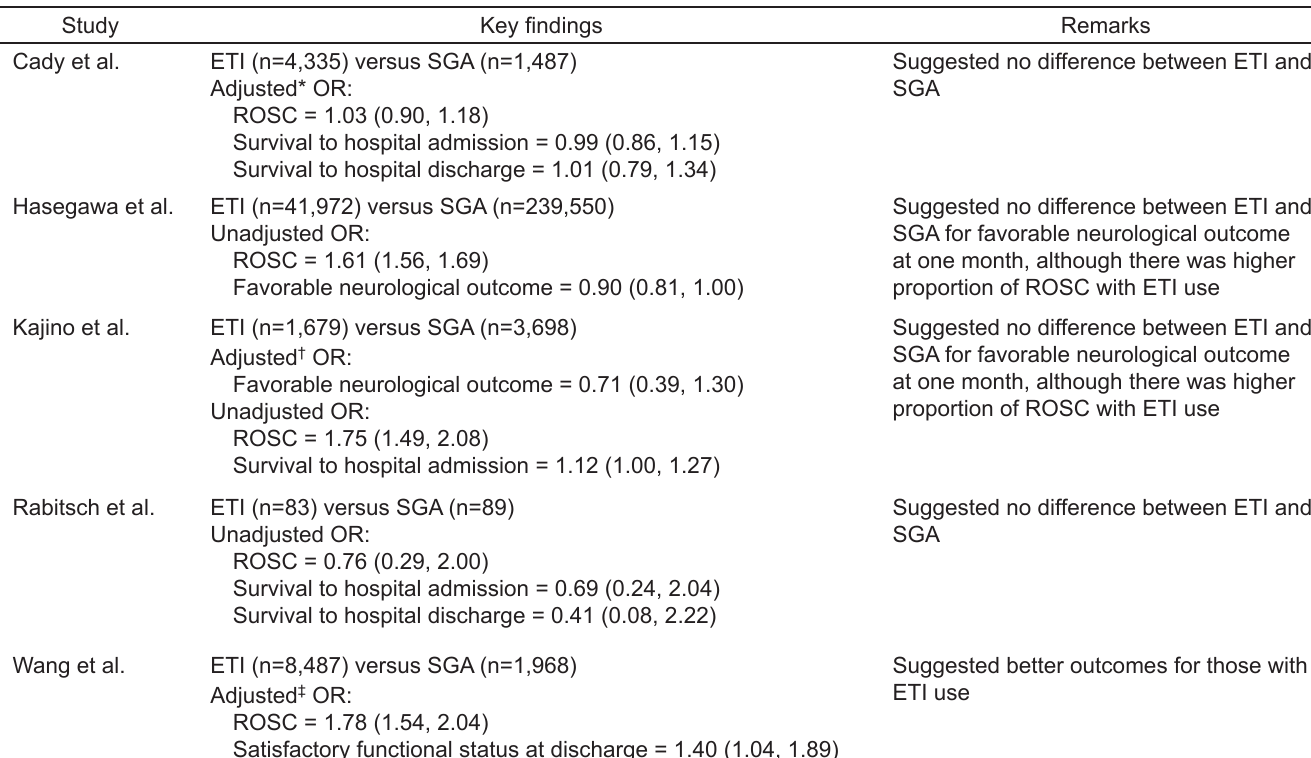
Table 3. Adjusted and unadjusted odds ratio (OR) comparing endotracheal intubation (ETI) and supraglottic airways (SGA) for outcome